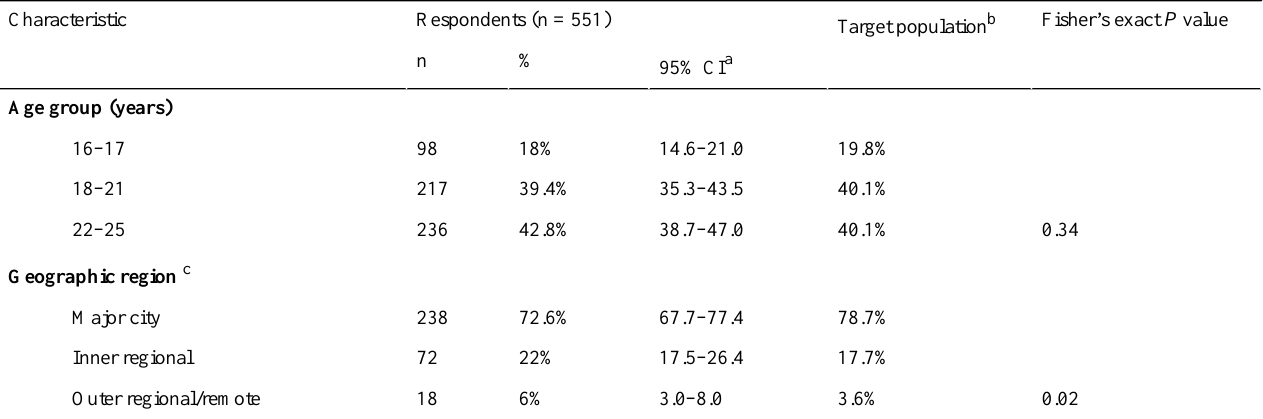
Table 2. Demographic characteristics of respondents who submitted an expression of